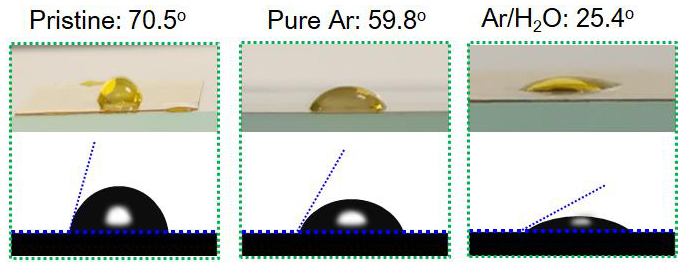
Figure 5. Water contact angle of untreated PI film and the PI films modified by pure Ar and Ar/H 2 O microplasma jets.